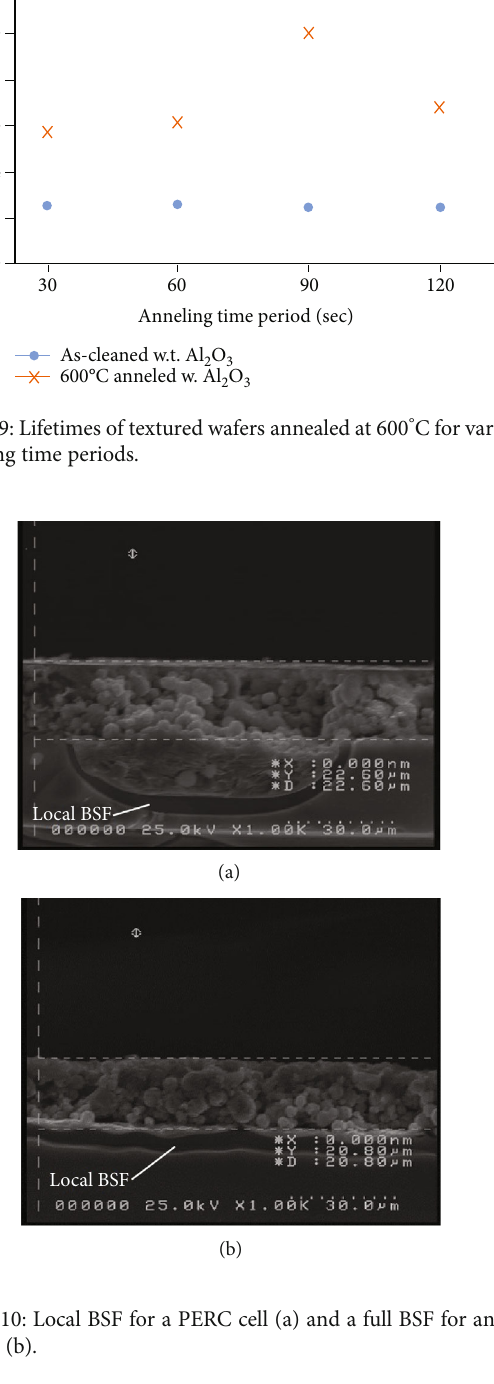
Table 1: Electric parameters and conversion e ffi ciencies measured